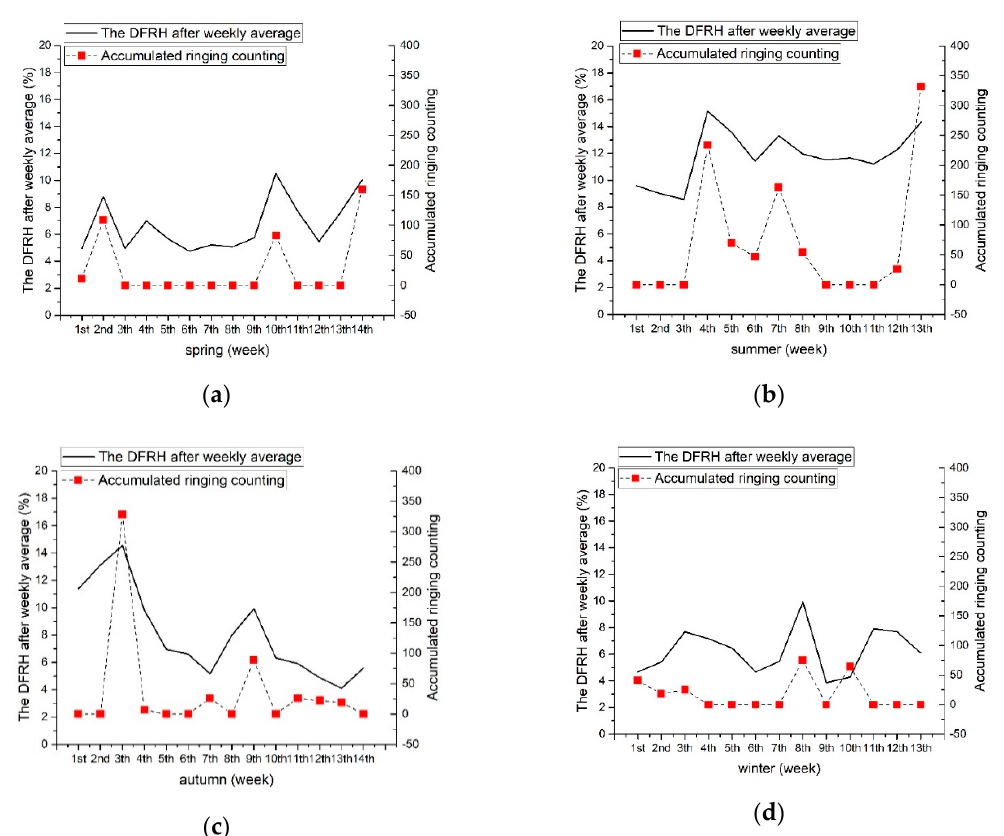
Figure 11. Relationship between DFRH after weekly average and the accumulated ringing counting in spring, summer, autumn, and winter.